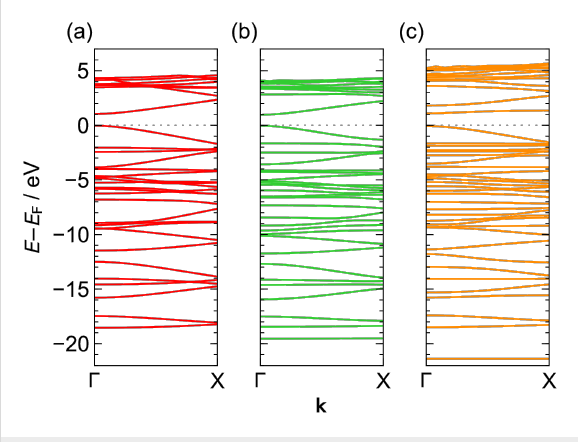
Figure 6: Calculated band structure of (a) unsubstituted PTp and of the substituted polymers (b) NH 2 PTp and (c) NO 2